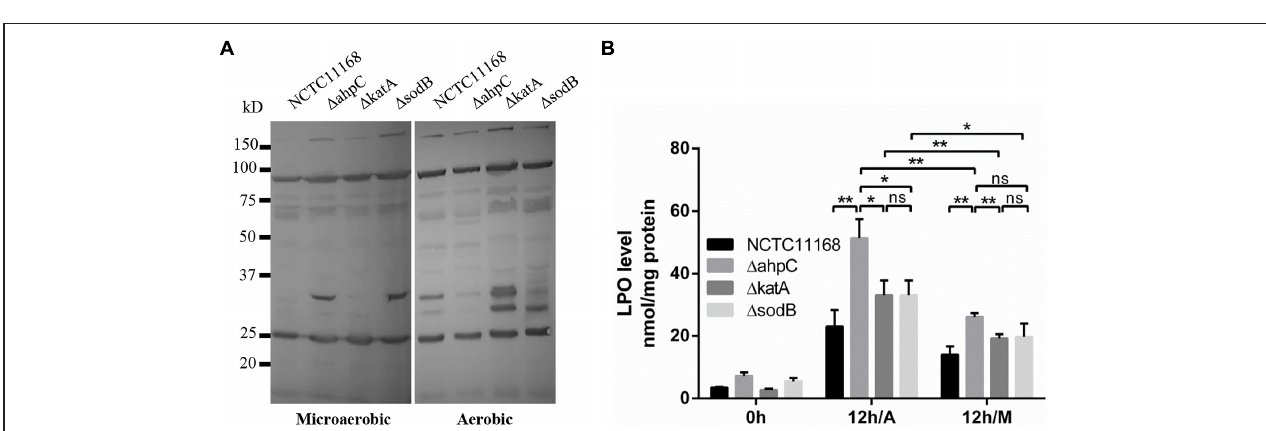
FIGURE 4 | Oxidation of proteins and lipids in the oxidative stress defense mutants under microaerobic and aerobic conditions. (A) Protein oxidation was measured by western blotting with monoclonal antibodies that recognize protein carbonylation. (B) Lipid peroxide (LPO) levels were increased in the oxidative stress defense mutants under aerobic condition. The LPO levels